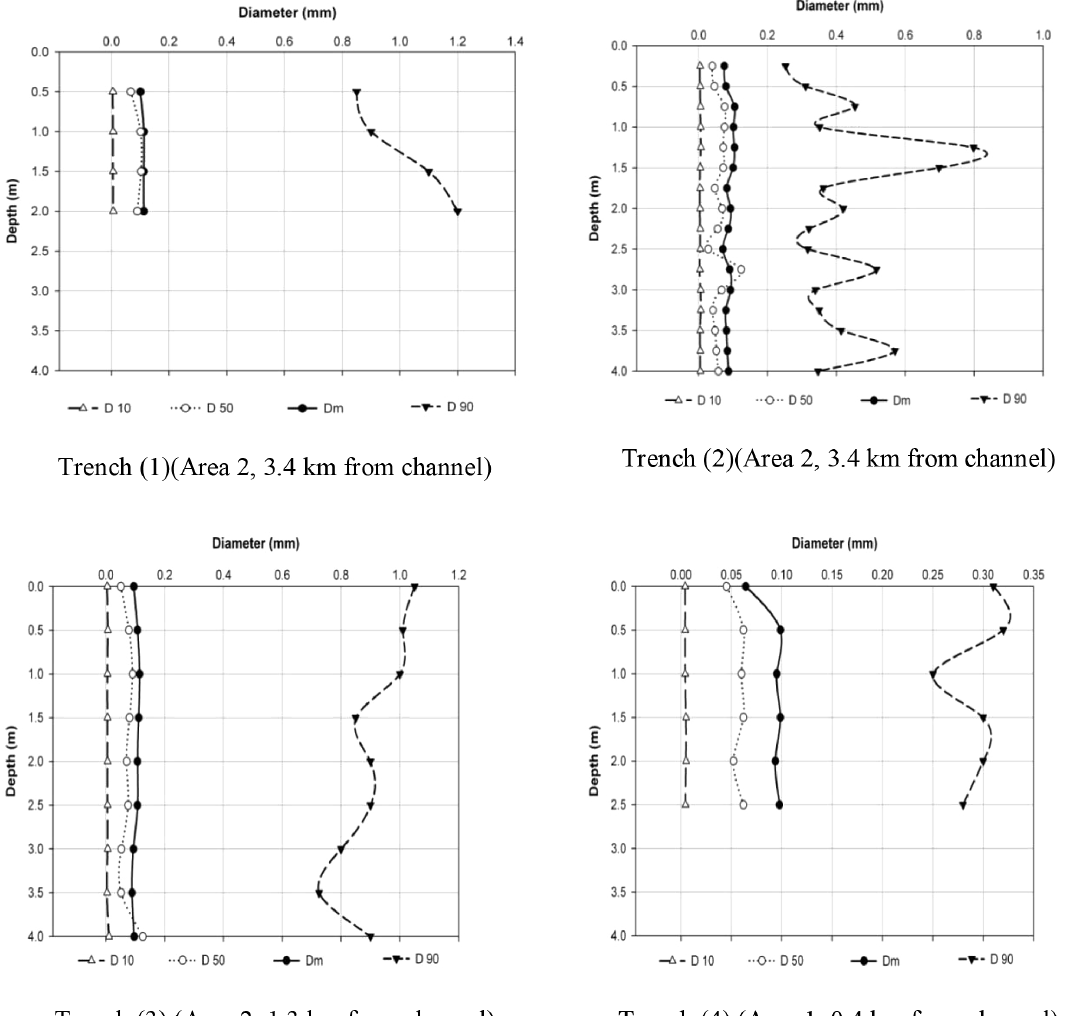
Figure 14. Soil stratification at the four